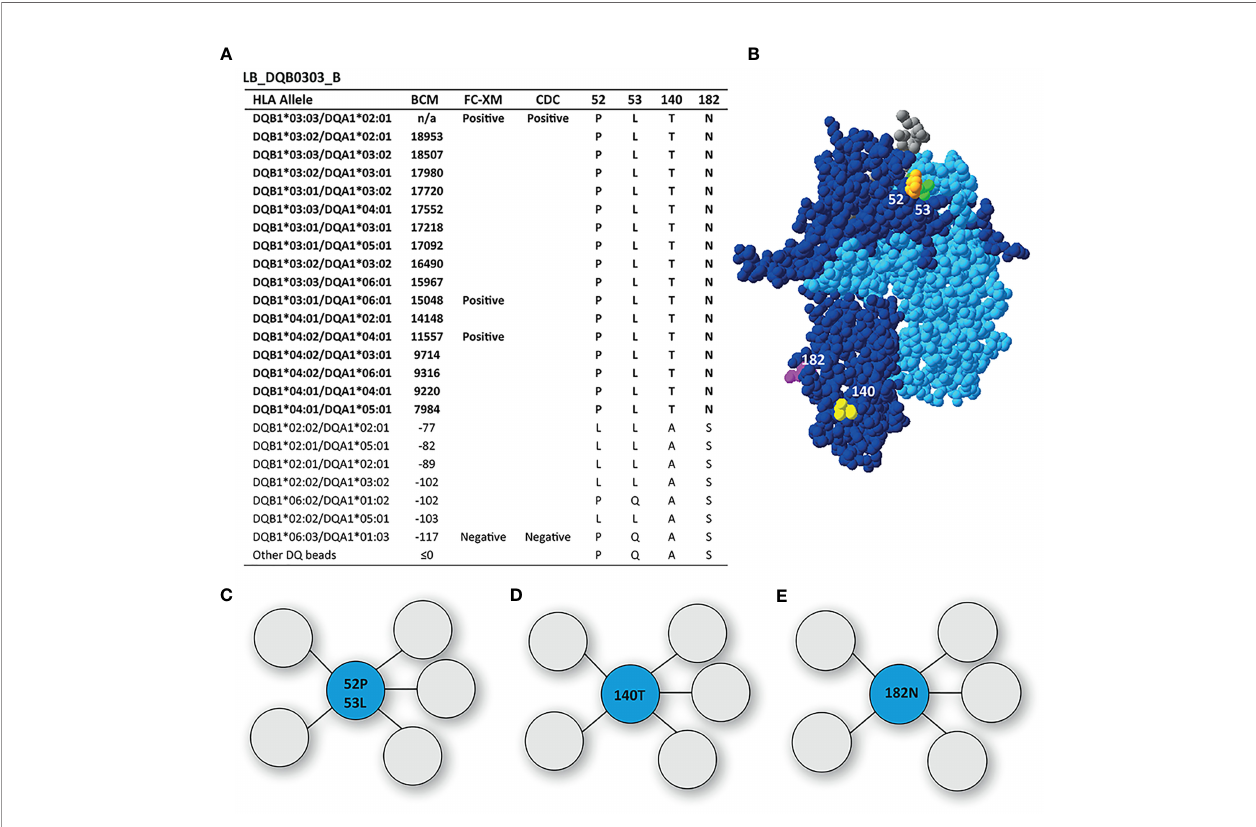
FIGURE 4 | Reactivity analysis of monoclonal antibody LB_DQB0303_B. (A) Comparison of the amino acid positions of interest of the HLA-DQB1 alleles on the reactive beads in the single antigen bead assay and a selection of the nonreactive HLA-DQB1 alleles. HLA-DQB1*03:03/DQA1*02:01 was not present in the single antigen bead panel. (B) Locations of amino acid 52L (orange), 53L (green), 140T (yellow) and 182N are indicated on the crystal structure of DQB1*03:02/ DQA1*03:01 (PBD: 4Z7U). The b chain is depicted in dark blue, the a chain in light blue, and the peptide in grey. (C) Schematic representation of the antibody footprint of LB_DQB0303_B interacting with 52P+53L, or 140T (D) or 182N (E) as the functional epitope (cyan). BCM, background corrected mean fl uorescence intensity; FC-XM, fl owcytometric crossmatch; CDC, complement dependent cytotoxicity; PBD, Protein Data